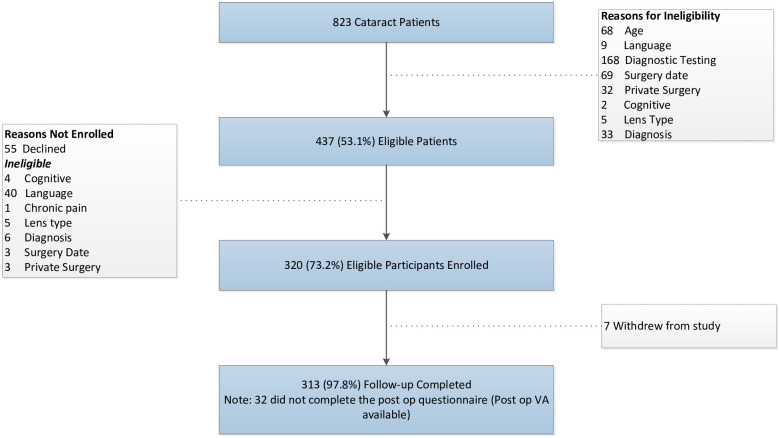
Patient recruitment.